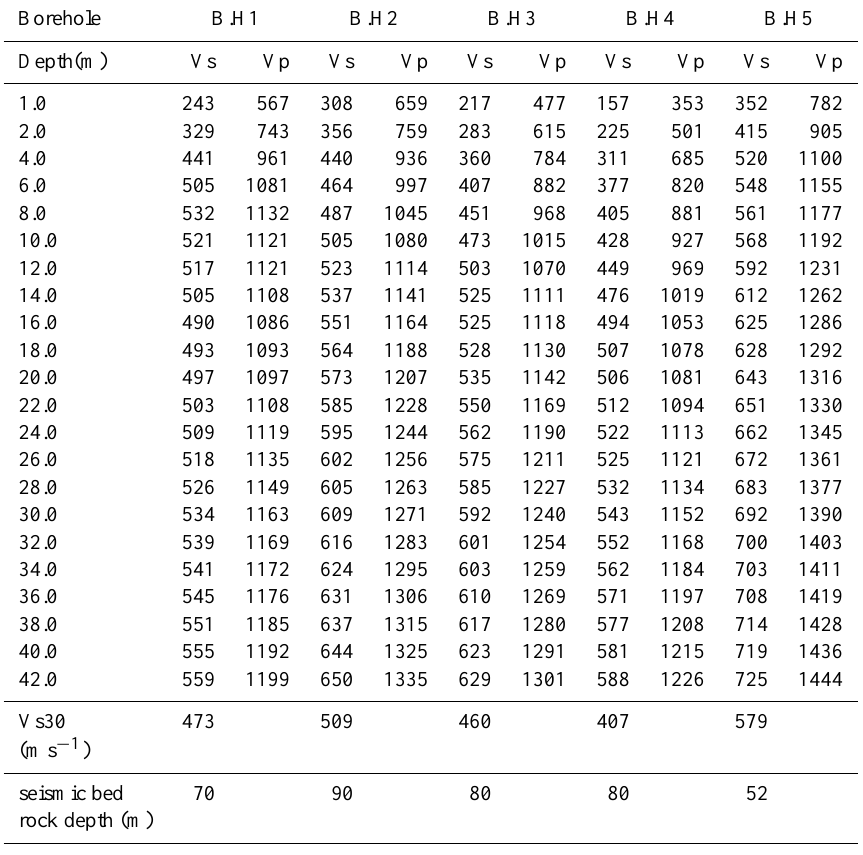
Table 3. Velocity of seismic waves (ms − 1 ) in Meybod city.